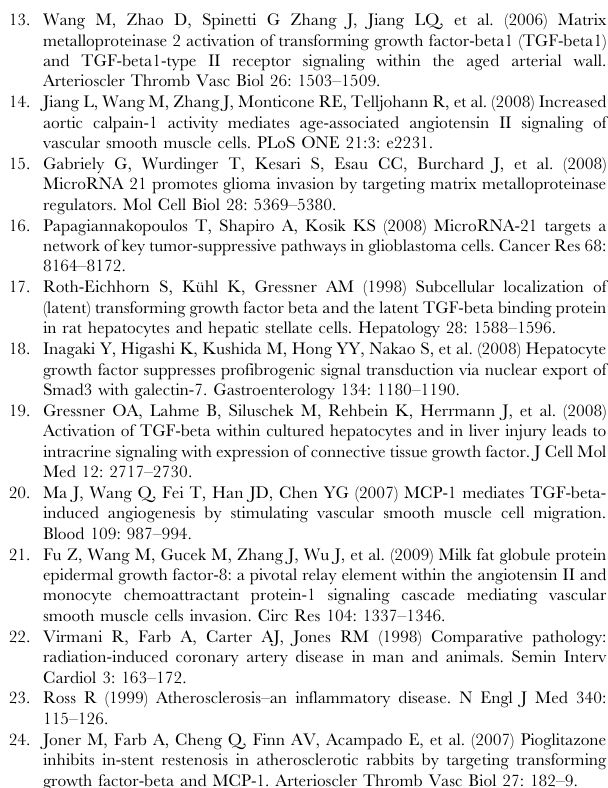
Figure S1 Cytoskeletal remodeling in the aortic wall and primary cultured VSMC with aging. A. Representative Western blots of a -SMA (upper), vimentin (middle), and desmin (lower) within the arterial wall (left panels) and VSMC (middle and right panels). B. Average data of a -SMA (upper panel), vimentin (middle panel), and desmin (lower panel). *p , 0.05, vs. 8 mo.